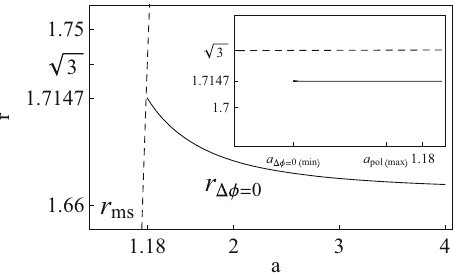
Fig. 7 Radii r (cid:4)φ = 0 of orbits with zero nodal shift (cid:4)φ in dependence on the spin parameter a and comparison with the loci of marginally stable orbits r ms . For given dimensionless spin a the radii of the stable orbits are r < r ms ( a ). Hence all such orbits are stable. Note that the detail is approx. 10 4 -times horizontally